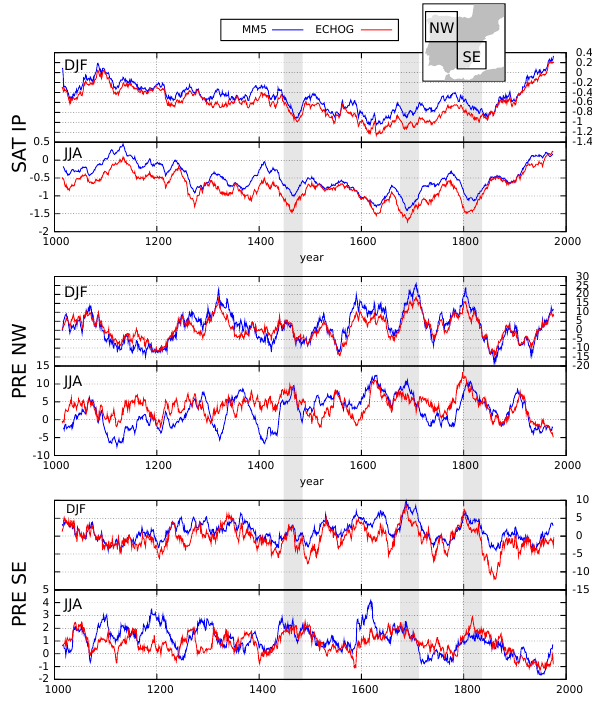
Fig. 11. Anomaly series of SAT over the IP (upper panel, in ◦ C) Northwest precipitation (middle panel, in mm/month) and South- east precipitation (lower panel, in mm/month) in winter (DJF) and summer (JJA), respectively. The NW and SE subdomains are represented in the grey map in the top-right corner of the figure. Red line represents the series for ECHO-G and blue line for ECHO- G+MM5. Ocean grid-cells are also included in the calculations. Anomalies are calculated with respect to the period 1900–1990, and a 31-years running mean have been applied to all series. Grey bars indicate three cold periods discussed in the main text.